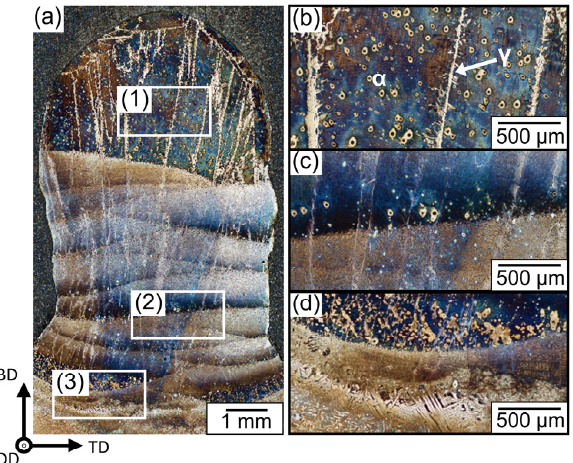
Figure 2. OM images obtained of the polished and etched BD-TD section; ( a ) overview of the cross-section; magnifications of the top layer ( 1 ), middle section ( 2 ) and first layer ( 3 ) are shown in ( b ), ( c , d ), respectively; the sample coordinate system is defined by the building direction (BD), deposition direction (DD) and transverse direction (TD).